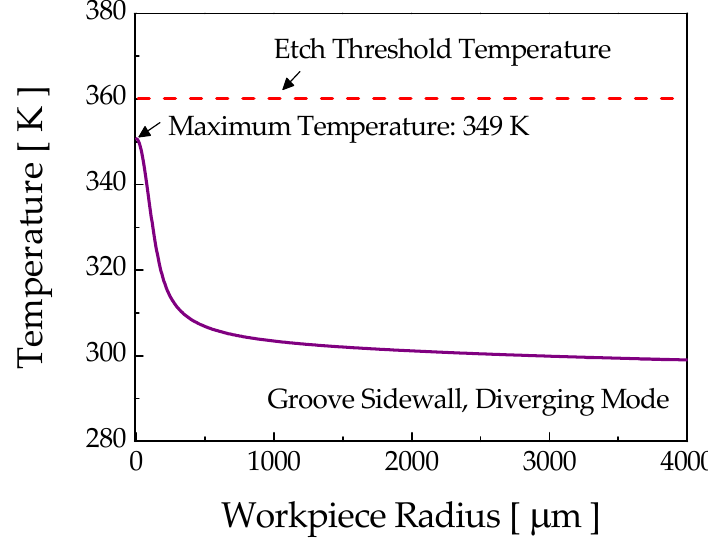
Figure 12. Sidewall temperature variation of the microgroove for the diverging mode.